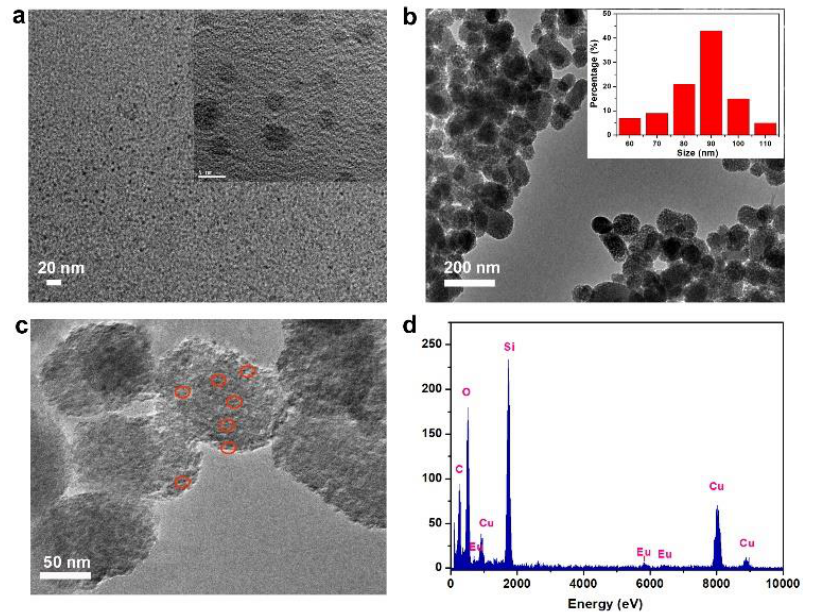
Figure 1. TEM images of SiCDs ( a ) and SiCDs@mMIP-cit-Eu probe ( b ). Inset: HRTEM image of SiCDs and size distribution image of SiCDs@mMIP-cit-Eu. ( c ) HRTEM image and ( d ) EDS spectra of SiCDs@mMIP-cit-Eu probe.